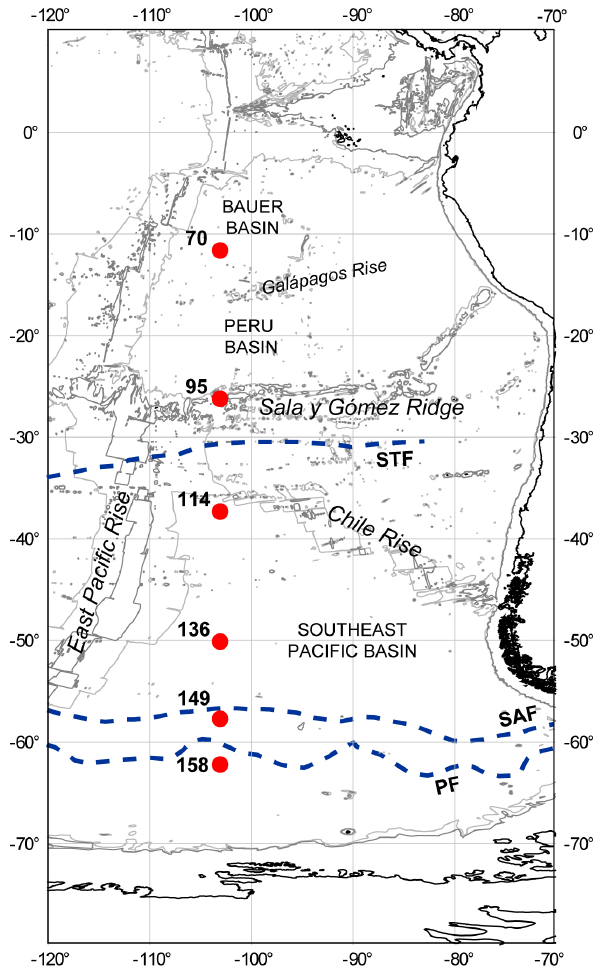
Fig. 1. Map of the eastern South Pacific Ocean showing loca- tions of stations from which samples were collected on expedition 33RO20071215. Dark and light gray lines represent the 3000m and 3500m isobaths, respectively. The dashed blue lines mark the loca- tion of the Subtropical Front (STF), Subantarctic Front (SAF) and Polar Front (PF) from Orsi et al.